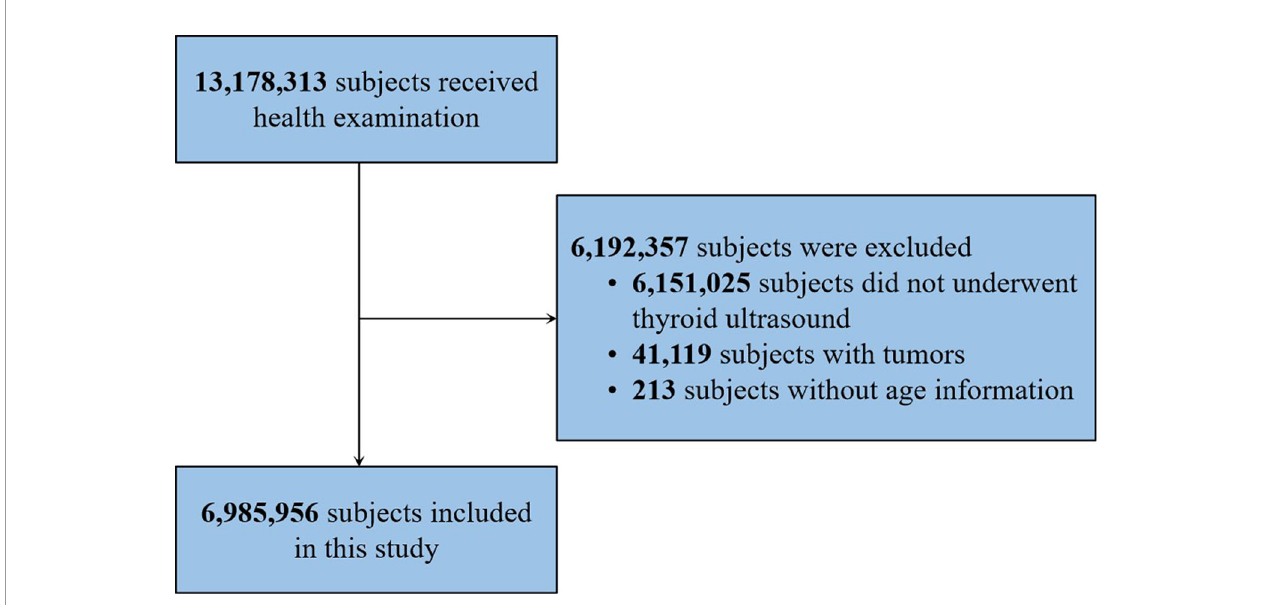
FIGURE 1 | Flowchart of subject